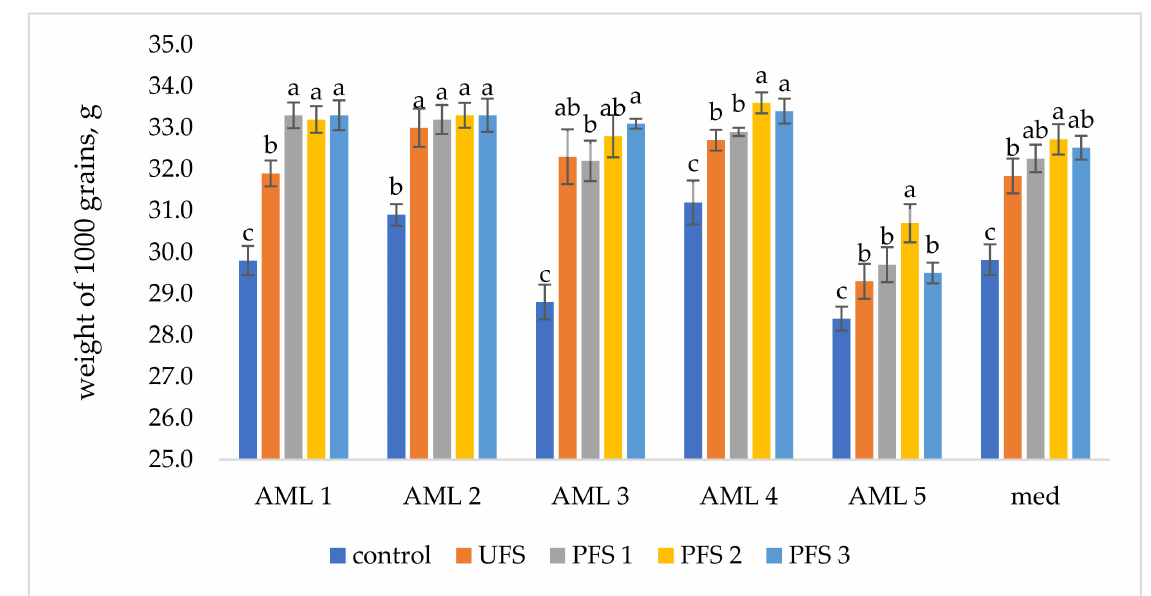
Figure 11. Weight of 1000 grains of oats in the